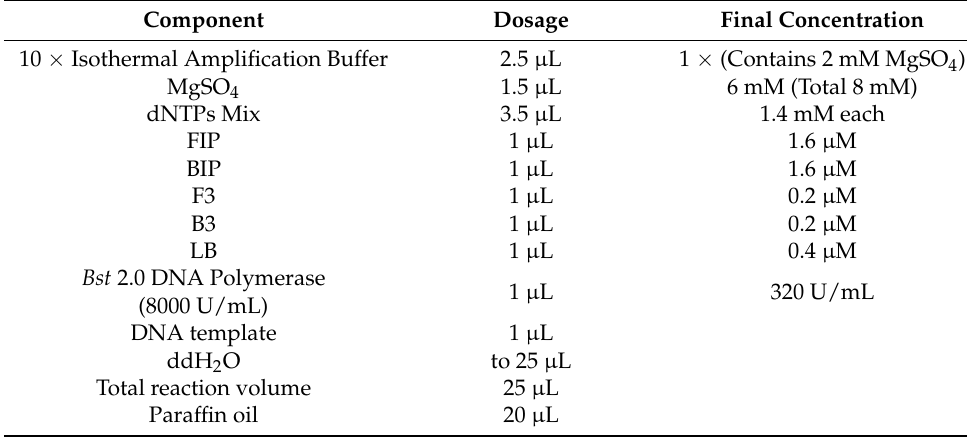
Table 4. LAMP reaction system (25 µ